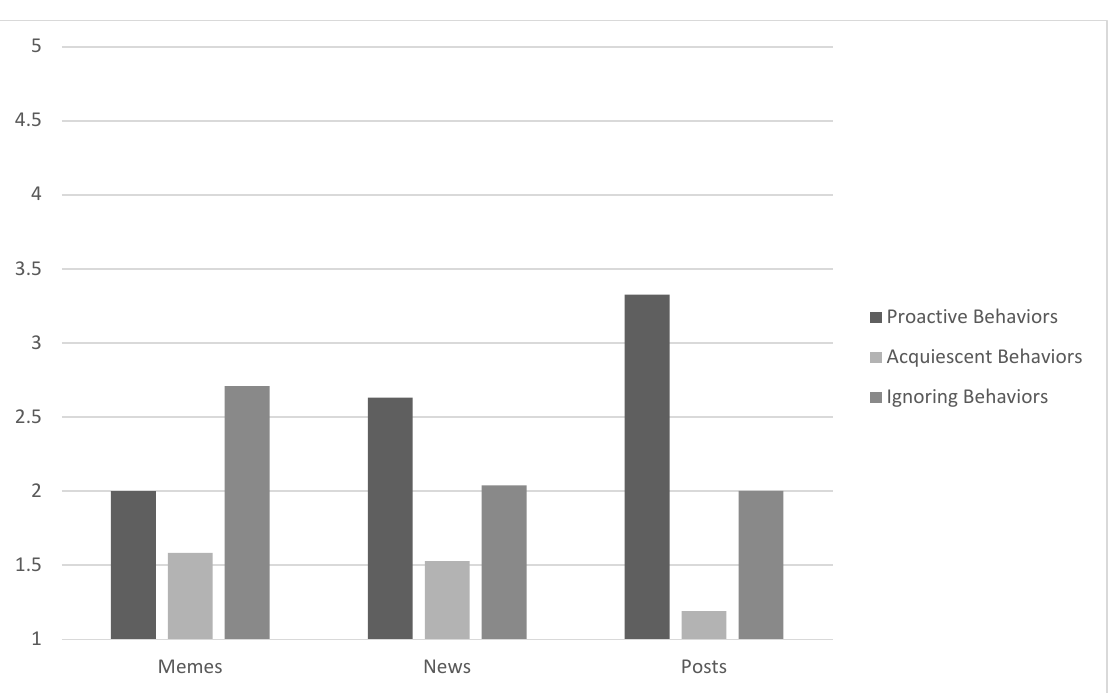
Figure 1. Differences between perceived offensiveness of memes, news, and posts by individuals with high vs. low heterogenous online network.